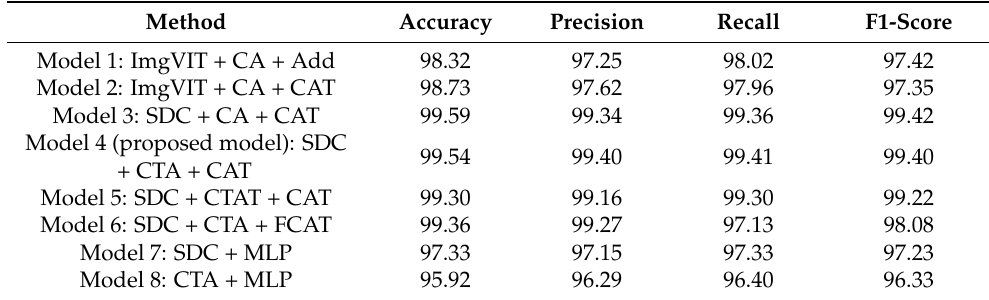
Comparisons of accuracy, precision, recall, and F1-score of the model with different